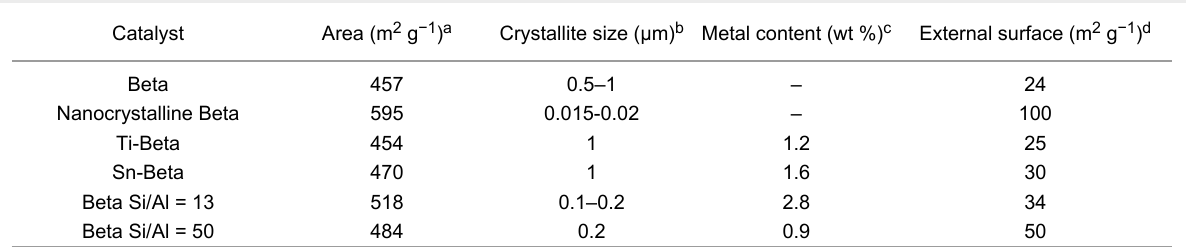
Table 1: Textural characteristic of the studied materials.